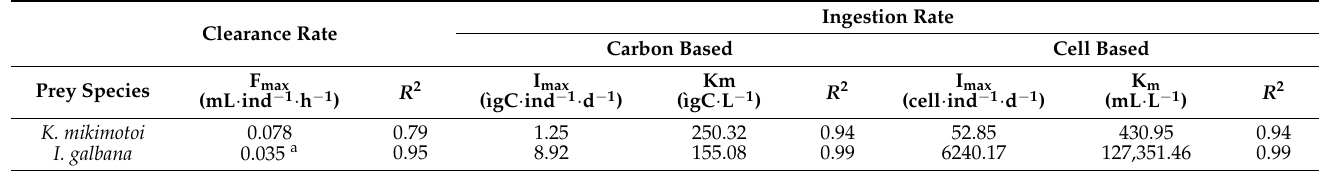
Table 3. Maximum ingestion (I max ) and clearance (F max ) rates, half-saturation prey concentration (K m ) estimated by Holling Type III functional response model.